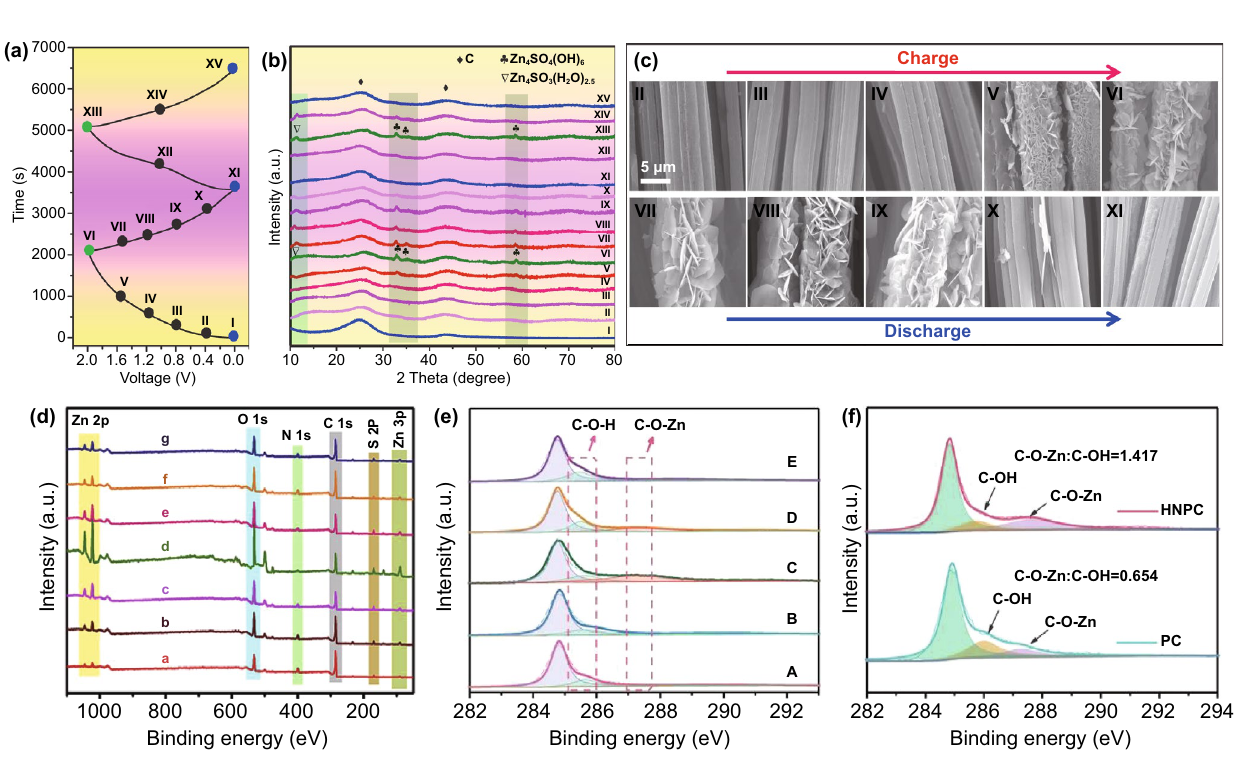
Fig. 9 a GCD profiles of ACC//Zn x MnO 2 ZHSCs at 2 mA cm −2 . b Corresponding ex‑situ XRD patterns and c SEM images of ACC anodes at different charge/discharge states. Reproduced with permission from Ref. [34]. Copyright 2020, Wiley–VCH. d Ex‑situ XPS spectra of carbon cathodes at various states, discharging from a to d and charging from d to g . Reproduced with permission from Ref. [77]. Copyright 2020, Else‑ vier. e Ex‑situ C 1 s XPS spectra of HNPC cathodes, discharging from A to C and charging from C to E. f C 1 s XPS spectra of PC and HNPC cathodes at 0 V. Reproduced with permission from Ref. [85]. Copyright 2019,